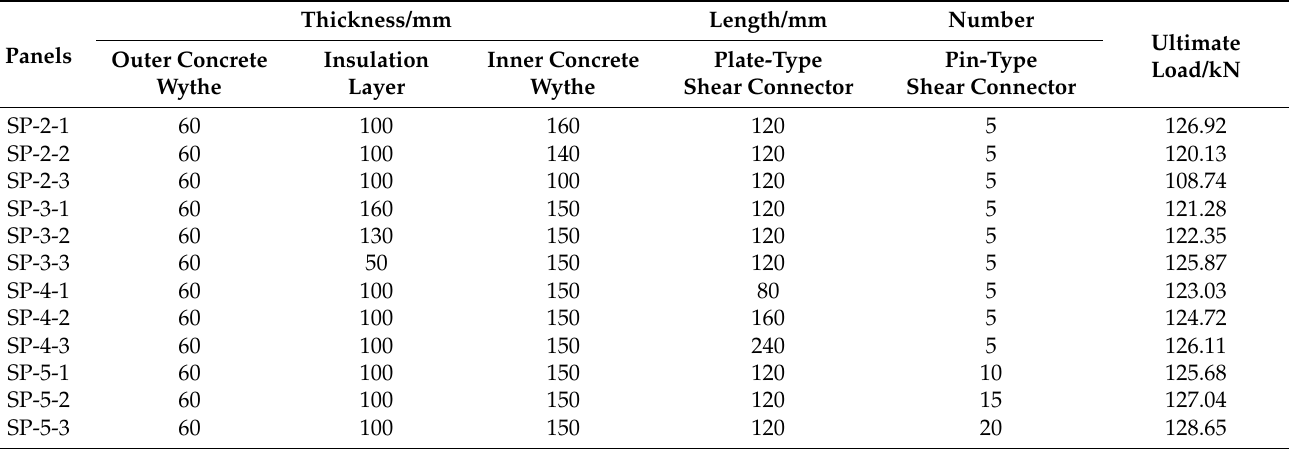
Table 6. Finite-element calculation